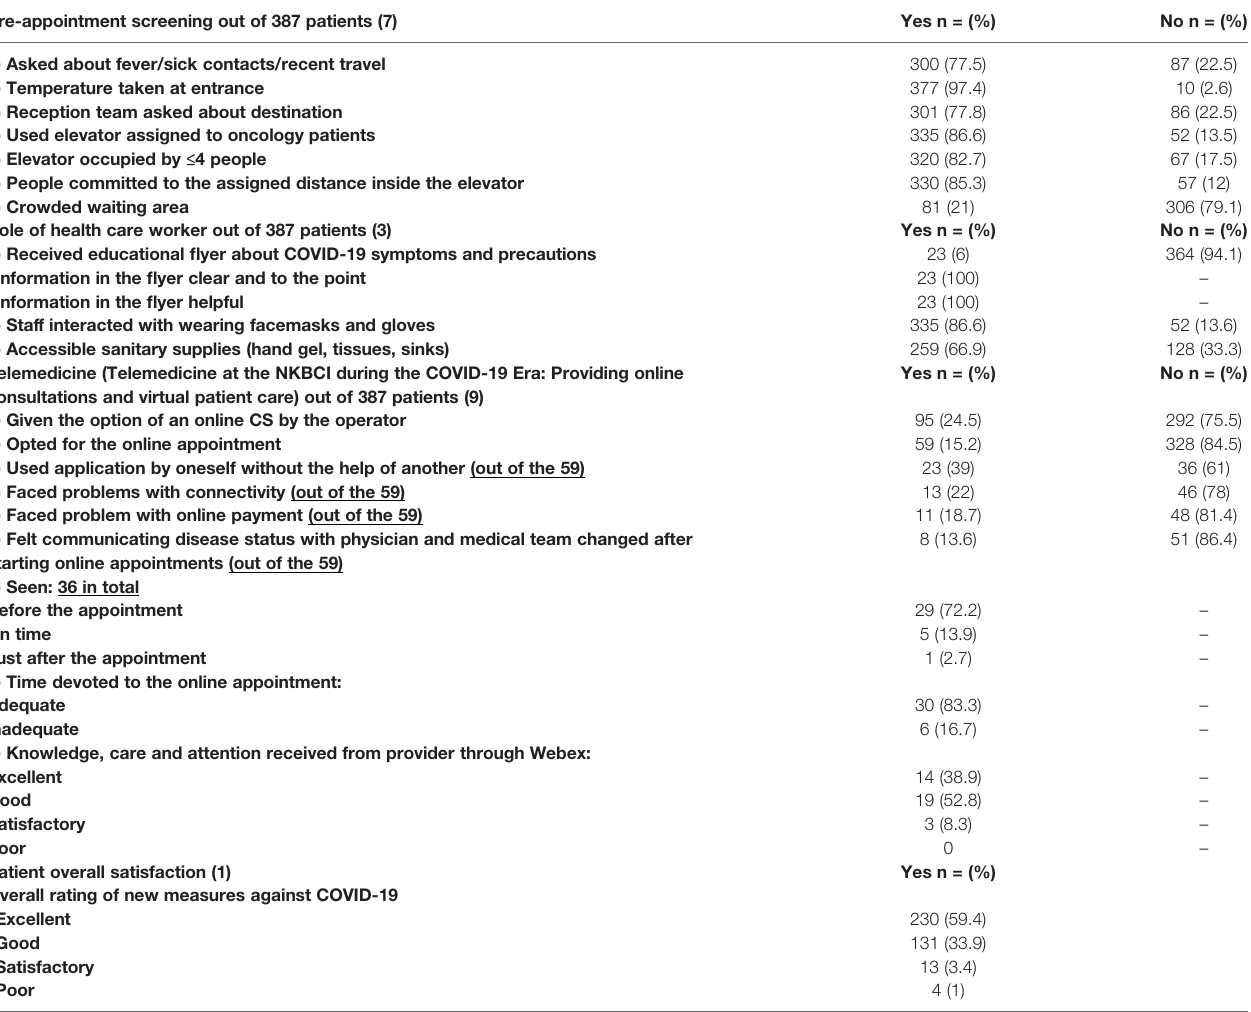
TABLE 2 | Survey questionnaire results with values of positive and negative respondents (20